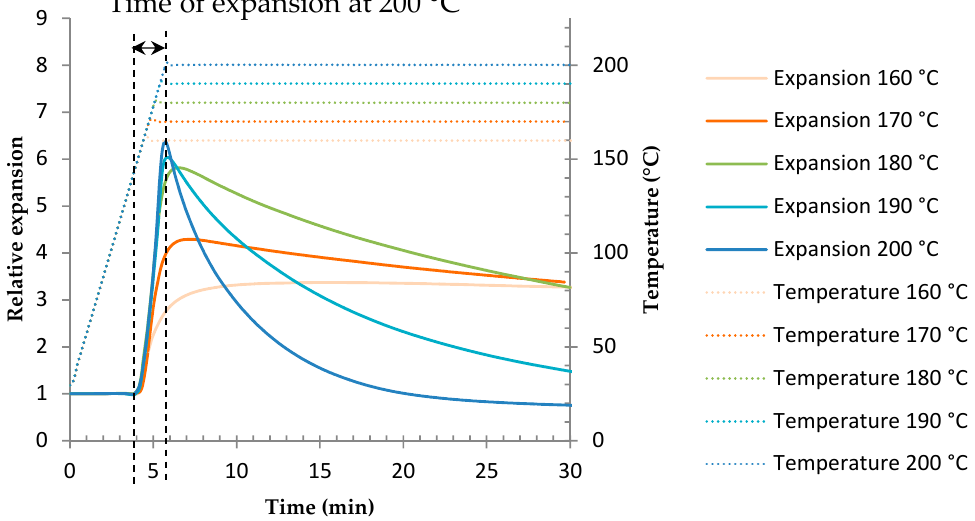
Figure 11. TMA of expandable microspheres Expancel® 950 DU 80 at various temperatures.